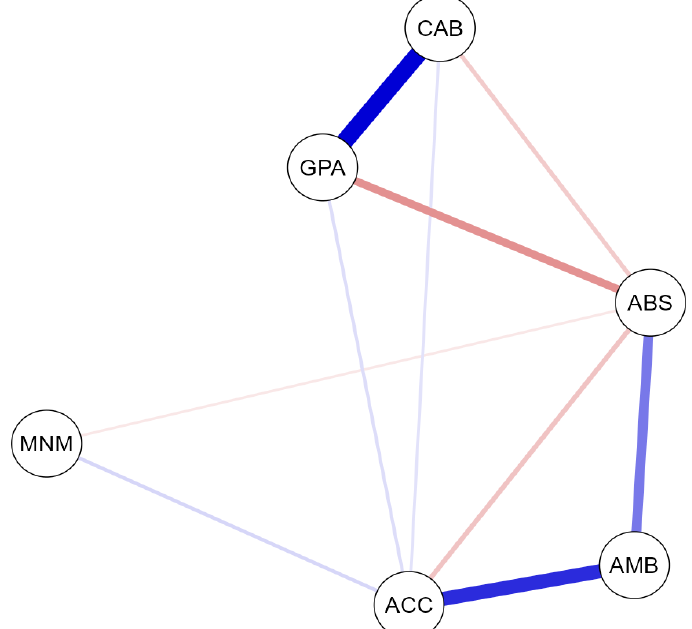
Figure 1. Graphical representation of the correlations between ISS subscales, STID-2 total score and GPA in general sample of school students ( N = 106). Note : Blue lines are positive correlations, and red lines are negative correlations; line thickness corresponds to the value of the correlation coefficient. ACC is Acceptance , AMB is Ambivalence, ABS is Absolutization, and MNM is Minimization ; CAB is cognitive abilities (total score of STID-2).